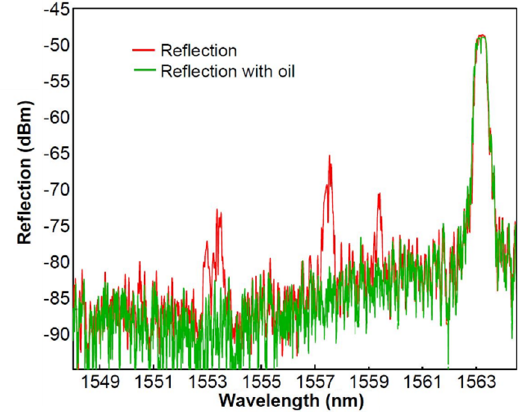
Fig. 1. Reflection spectra of a grating in a GMMF .